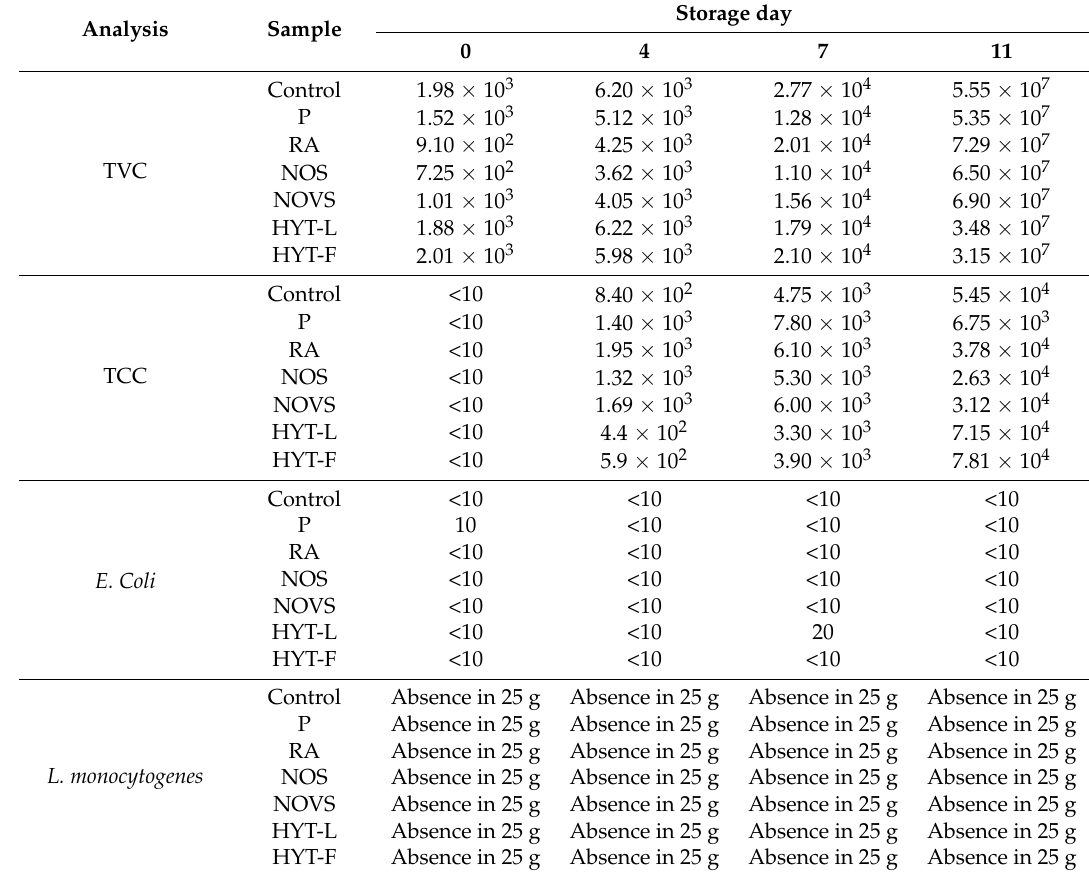
Table 5. Microbiological results (cfu/g) of fish patties analysis at days 0, 4, 7 and 11 under refrigerated